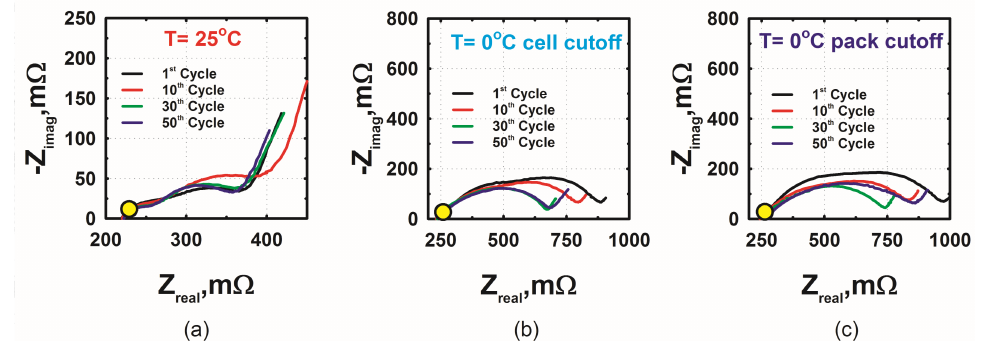
Figure 7. Pack-level impedance of 4S packs at ( a ) 25 ◦ C and ( b ) 0 ◦ C with discharge cutoffs when the first cell reaches 2.75 V and ( c ) when the pack discharge voltage reaches 11.0 V after 1st, 10th, 30th, & 50th discharge cycles. Yellow circles identify the impedance at 316 Hz during the 1st